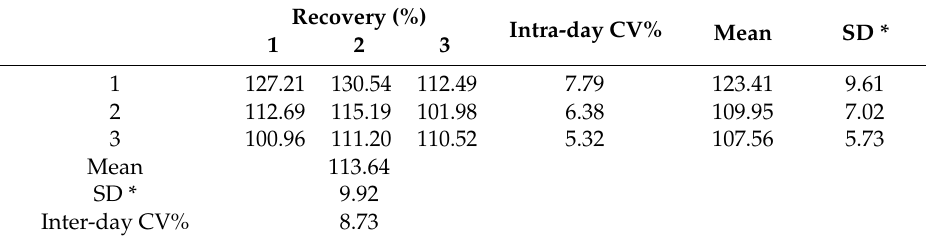
Table 2. The results of recovery for an in-house rhGH-Fc